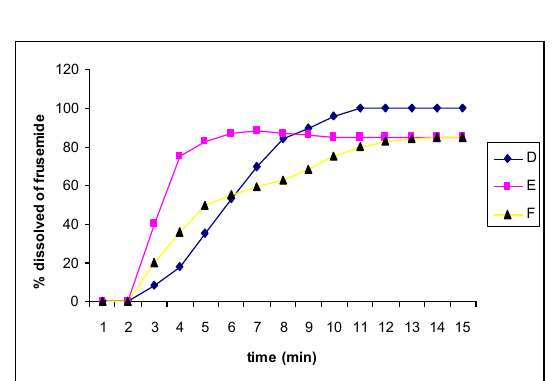
formula (A, B and C)